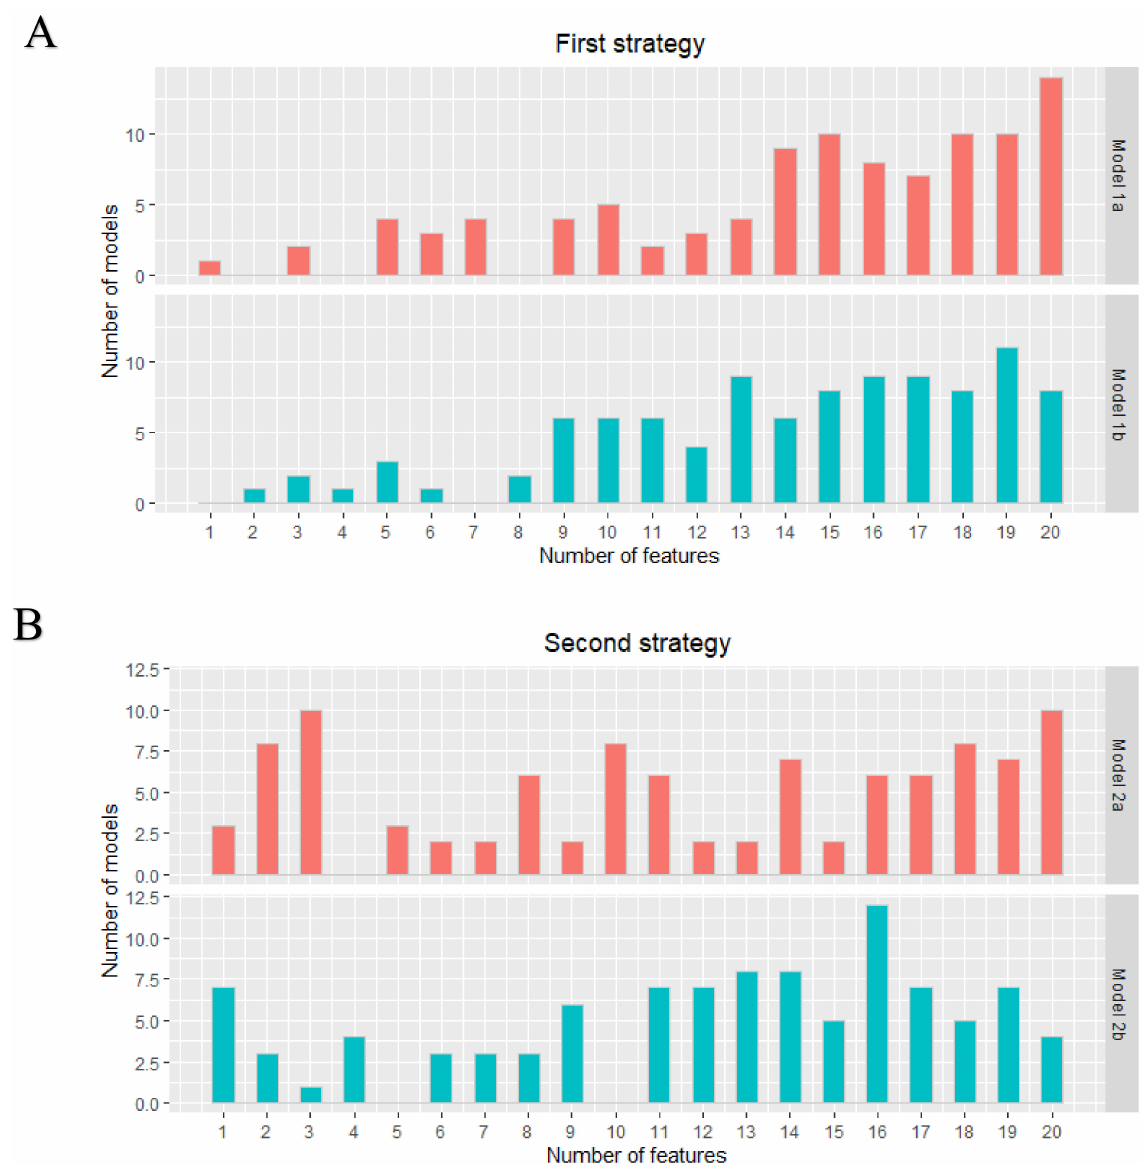
Figure 1. First ( A ) and second ( B ) strategy: distribution of the number of features in each developed model. The two different models in both strategies were all developed 100